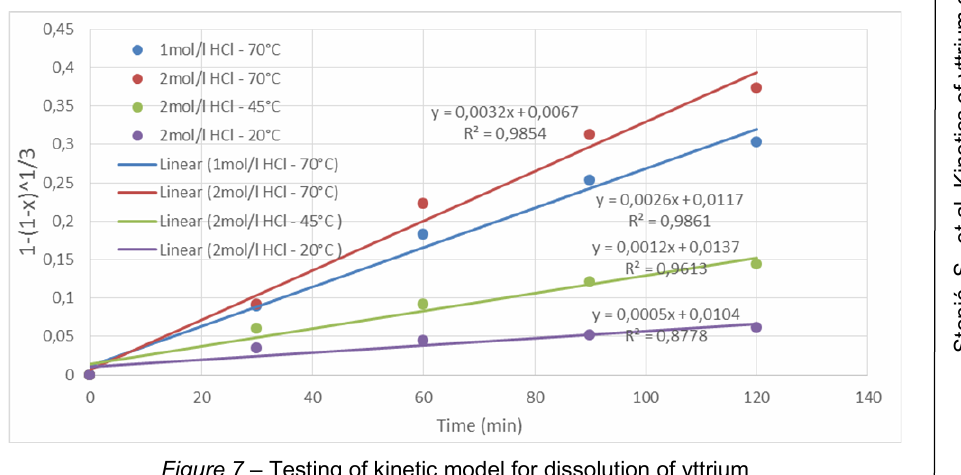
Figure 7 – Testing of kinetic model for dissolution of yttrium Рис . 7 – Тест кинетической модели растворения иттрия Slika 7 – Ispitivanje kineti č kog modela rastvaranja